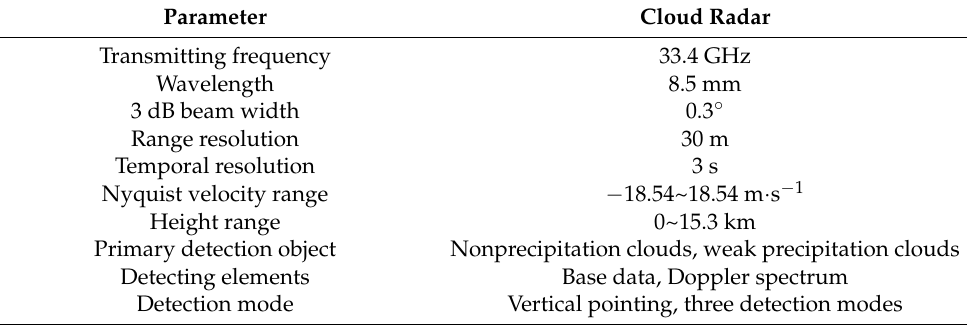
Table 1. Main specifications of the cloud radar.